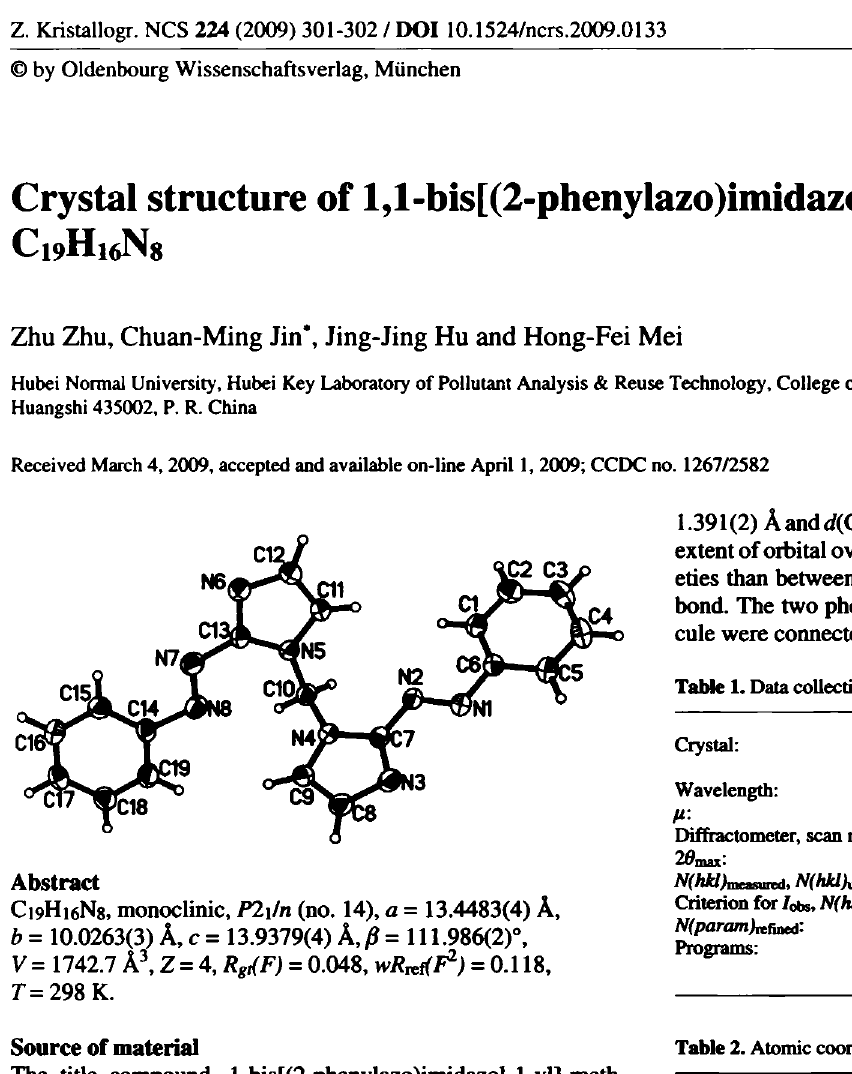
Table 2. Atomic coordinates and displacement parameters (in Â 2